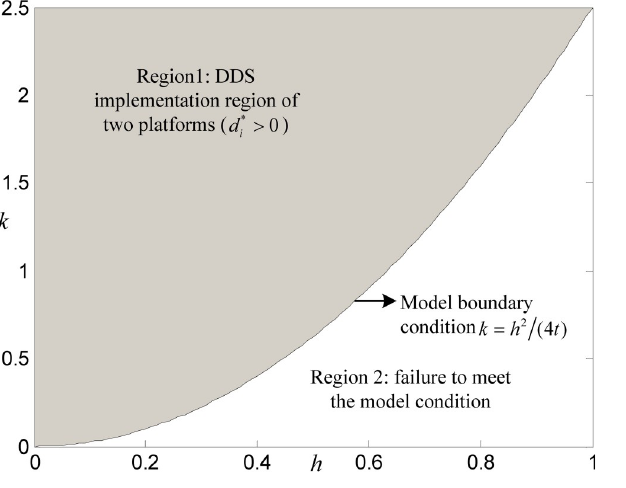
Fig 2. A feasible region of DDS implementation (with k and h